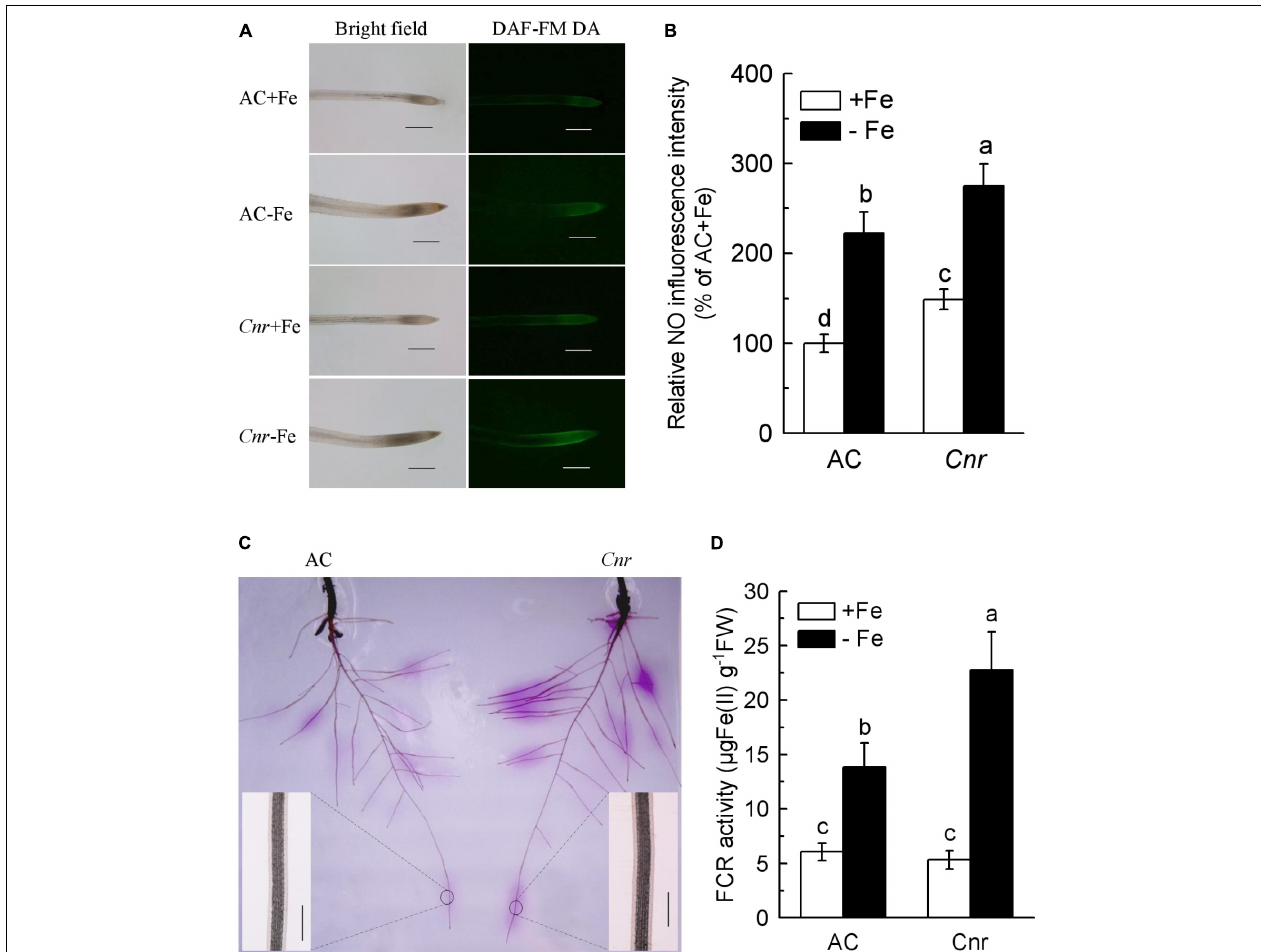
FIGURE 1 | Increased Fe-deficiency responses in colorless non-ripening ( Cnr ) roots compared to AC plants. (A) Examination of endogenous nitric oxide (NO) levels. Uniform seedlings of AC and Cnr were subjected to Fe-sufficient (+Fe) or Fe-deficient (–Fe) conditions for 3 days. At least 10 seedlings were examined for each treatment and the representative photos were given. Bar = 500 µ m. (B) Quantification of the NO fluorescence intensity using Adobe Photoshop software. (C) In-gel localization of Fe-deficiency-induced root ferric chelate reductase (FCR) activity. Enlarged inlet images show detailed localization patterns of FCR along root tip under –Fe conditions. Bar = 500 µ m. (D) The induction of FCR activity under Fe deficiency. Data are means ± SD ( n = 6). Different letters indicate significant differences between AC and Cnr under +Fe or –Fe treatment (Tukey’s test, P ≤